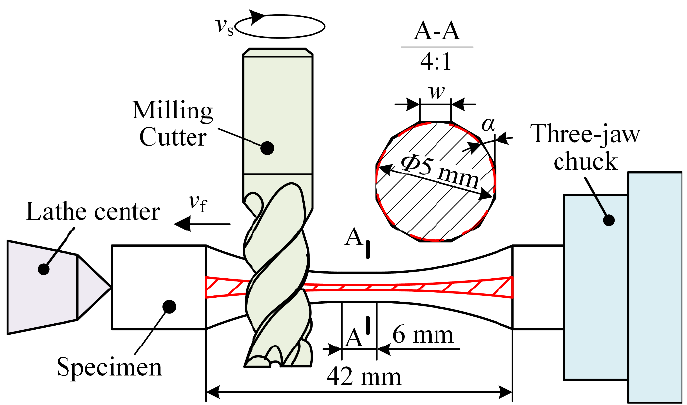
Figure 1. Schematic diagram of milling 20Cr and TC17 specimens.